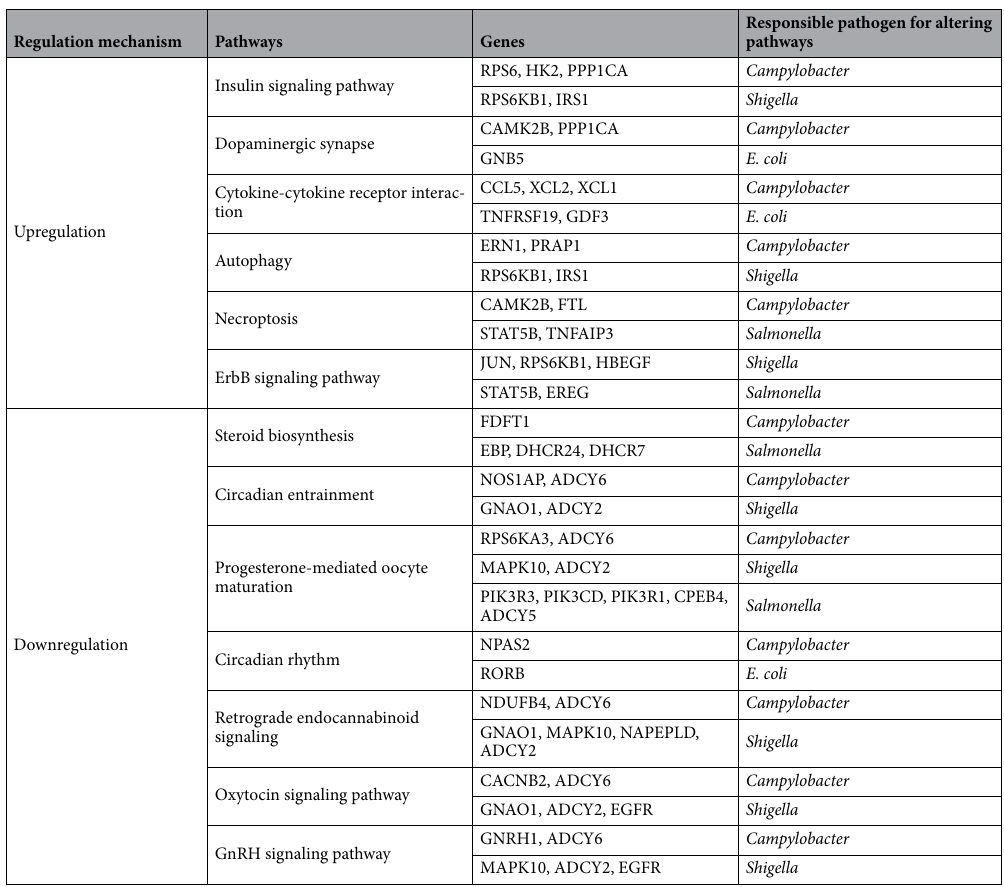
Table 1. Common altered pathways, names of the DEGs and the responsible pathogens for upregulation or downregulation of these